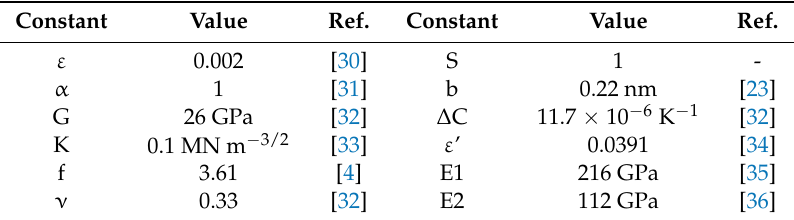
Table 3. Values of the constants used in calculations.